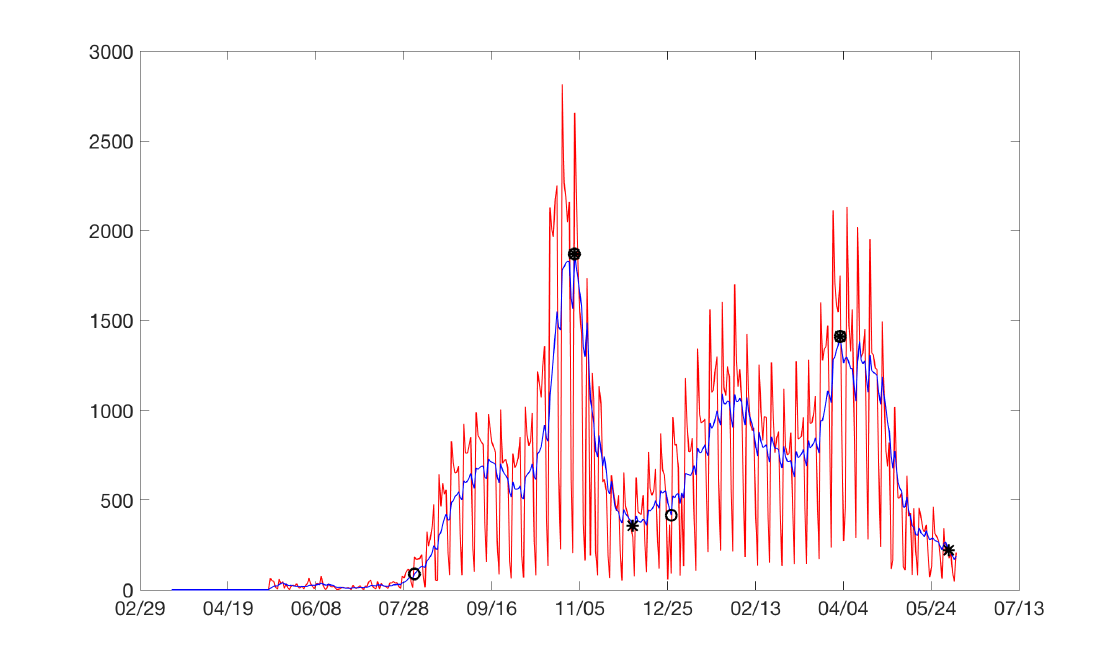
Figure A15. Marseille: on the horizontal axis is the date in days and on the vertical axis are the daily